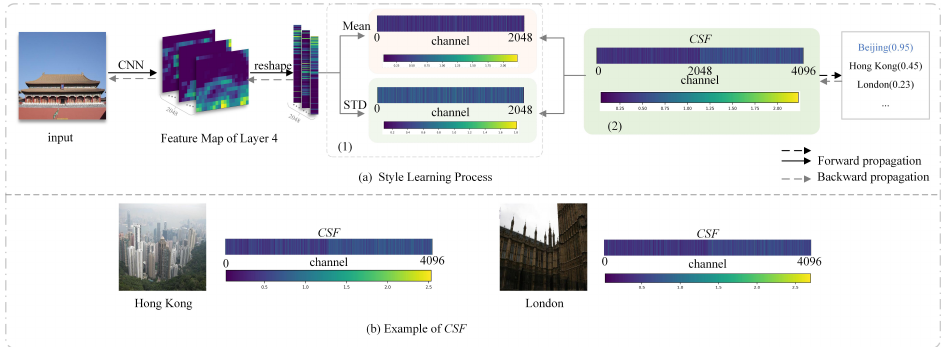
Figure 2. Deep style learning process and examples of city style